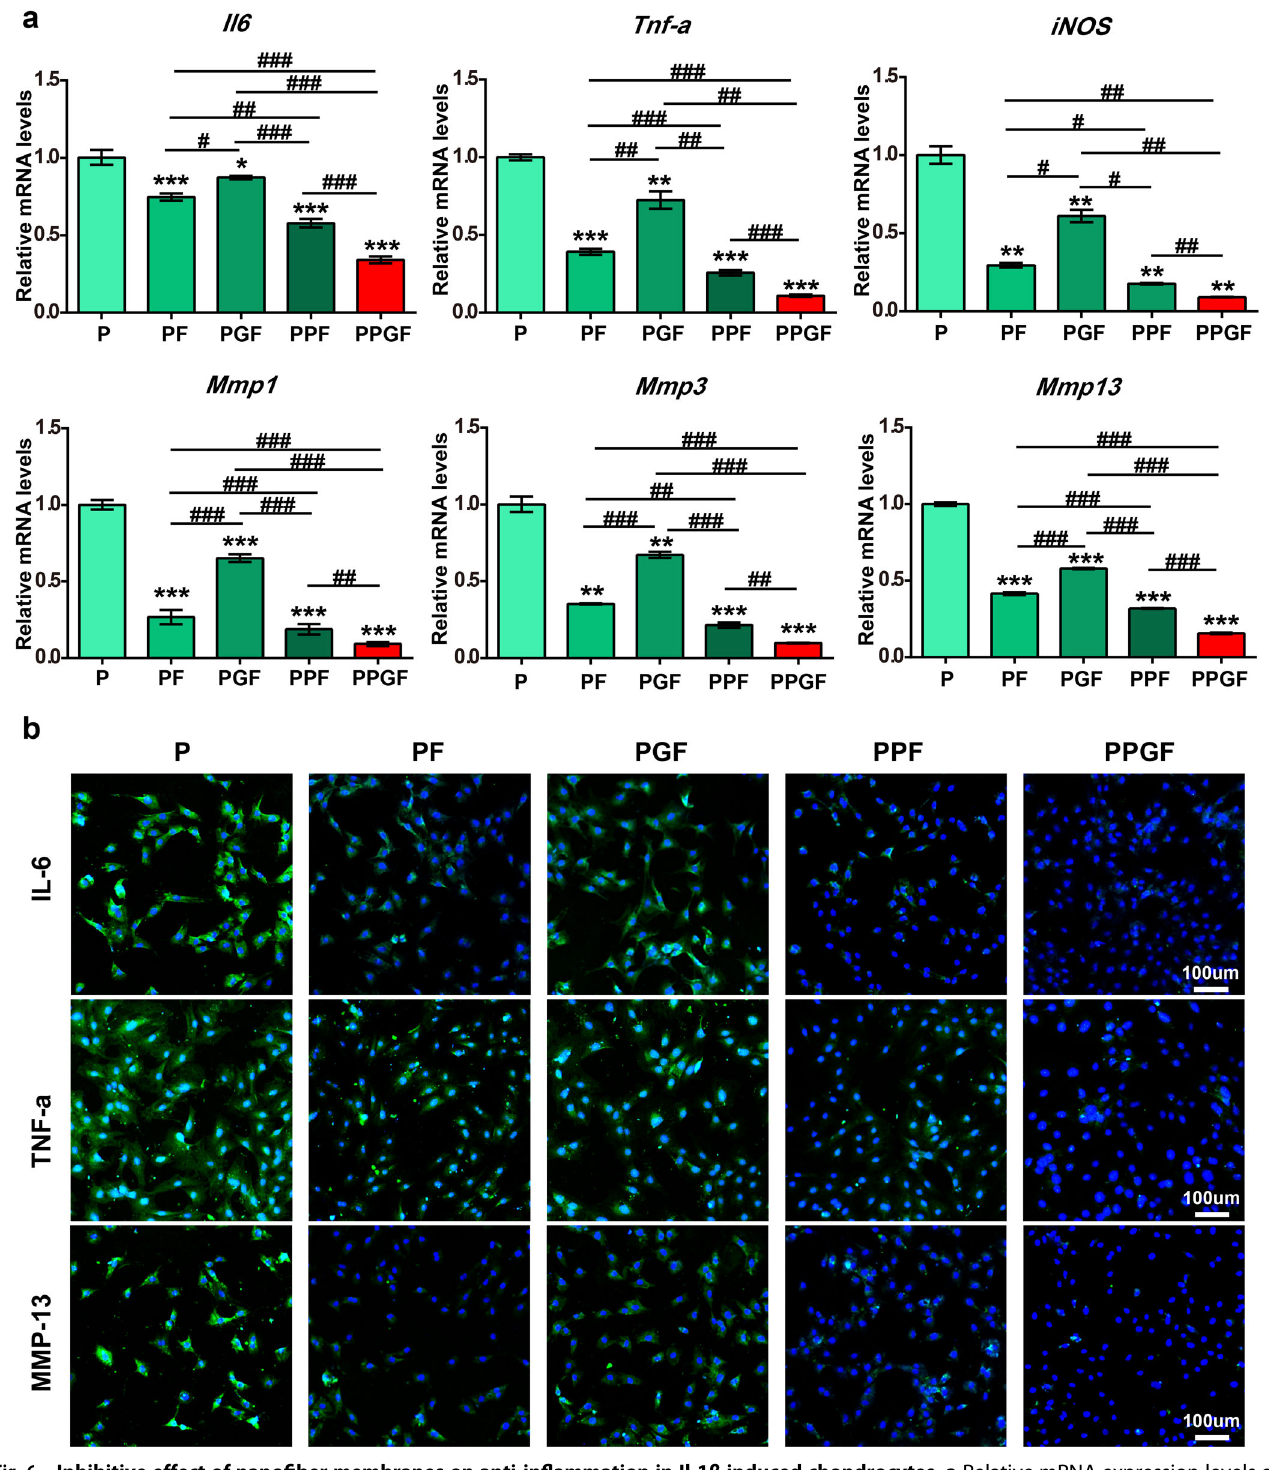
Fig. 6 Inhibitive effect of nano fi ber membranes on anti-in fl ammation in Il-1 β induced chondrocytes. a Relative mRNA expression levels of Il6, Tnf-a, iNos, Mmp1, Mmp3, and Mmp13 in IL-1 β induced chondrocytes cultured on P, PGF, PF, PPF, or PPGF nano fi ber membranes. b Protein expression of MMP13, TNF-a, and IL6 in IL-1 β induced chondrocytes cultured on P, PGF, PF, PPF, or PPGF nano fi ber membranes (Scale bars, 100 µm). The values were presented as mean ± SD ( n = 3; statistics: one-way ANOVA; # means p < 0.01, ** , ## means p < 0.01, *** , ### means p < 0.001, * is the statistical difference compare with P group and # is the statistical difference between the pairwise